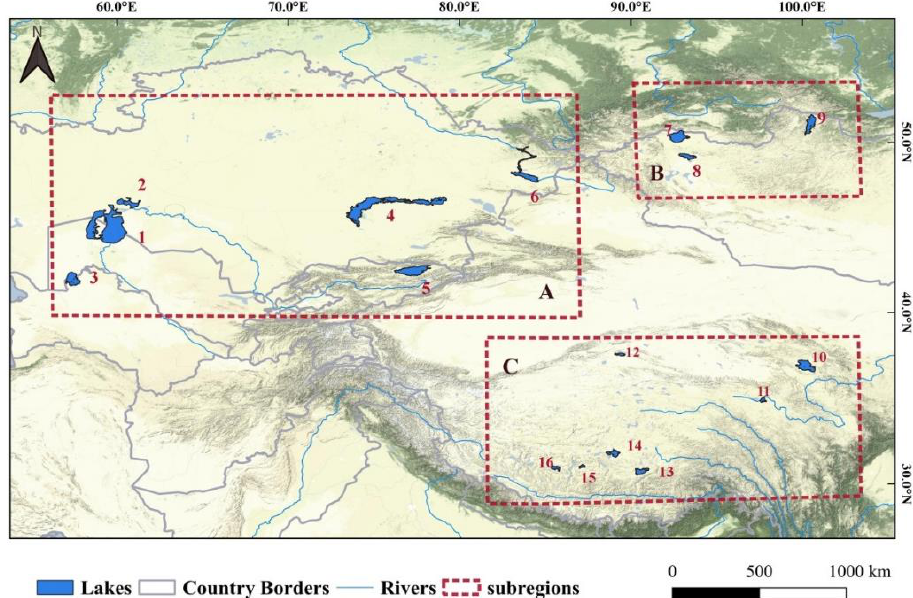
Figure 1. Locations of lakes selected in this study: The rectangles represent the spatial extent of general endorheic regions in ( A ) Central Asia, ( B ) the western Mongolian Plateau, and ( C ) the Tibetan Plateau. The lakes in Central Asia include (1) the South Aral Sea, (2) the North Aral Sea, (3) Sarykamysh, (4) Balkhash, (5) Issyk-Kul, and (6) Zaysan; The lakes in the Mongolian Plateau are (7) Uvs, (8) Hyargas, and (9) Hovsgol; The lakes in the Tibetan Plateau are (10) Qinghai, (11) Ngoring, (12) Ayakkum, (13) Namco, (14) Silingco, (15) Ngangzco, and (16) Zharinamco.